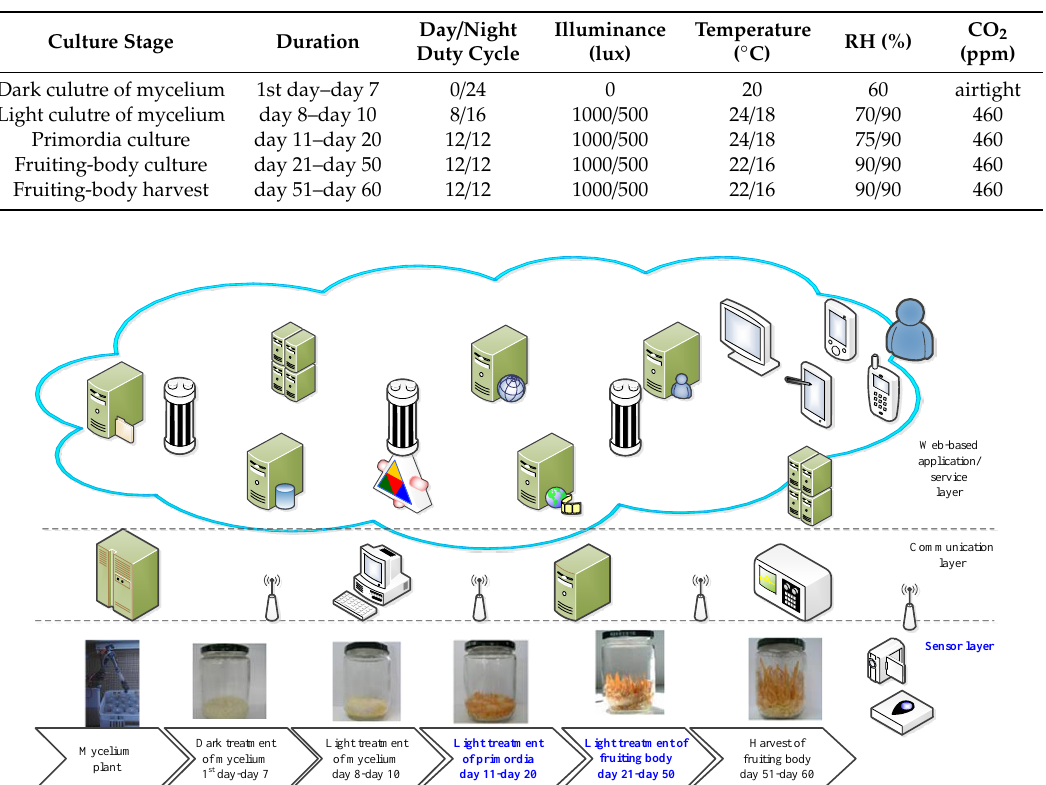
Table 1. Cultivation conditions for whole course of solid-state fermentation (SSF) culture process of C. militaris .